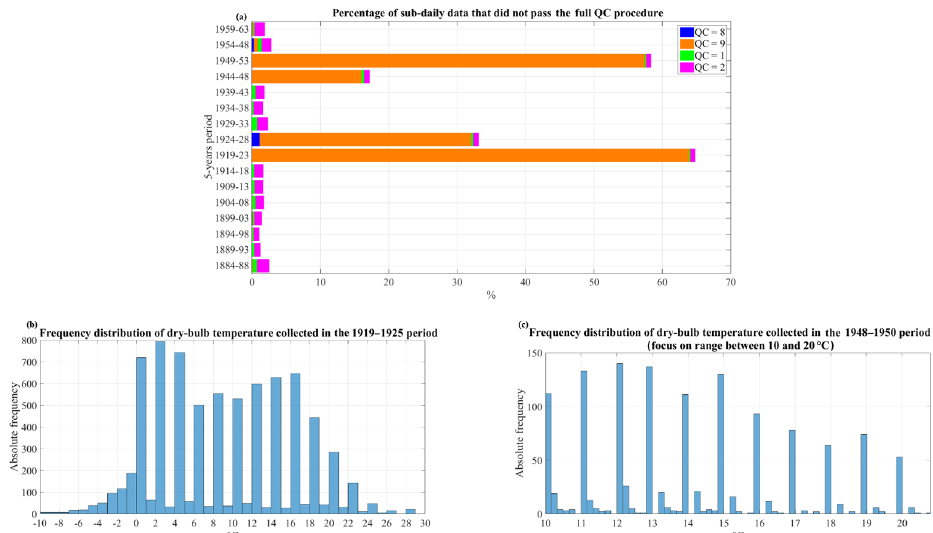
Figure 8. In panel (a) , colour-coded bars indicate the distribution over time, computed for a 5-year period, of the percentage of sub-daily data that did not pass the full QC procedure: QC = 8 (blue); QC = 9 (orange); QC = 1 (green); and QC = 2 (magenta). Panels (b) and (c) present the frequency distribution of dry-bulb temperature in the periods 1919–1925 and 1948–1950, respectively. It should be noticed that panel (c) only shows temperature values between 10 and 20 ◦ C. The bin width is 1.0 ◦ C in panel (b) and 0.2 ◦ C in panel (c) .